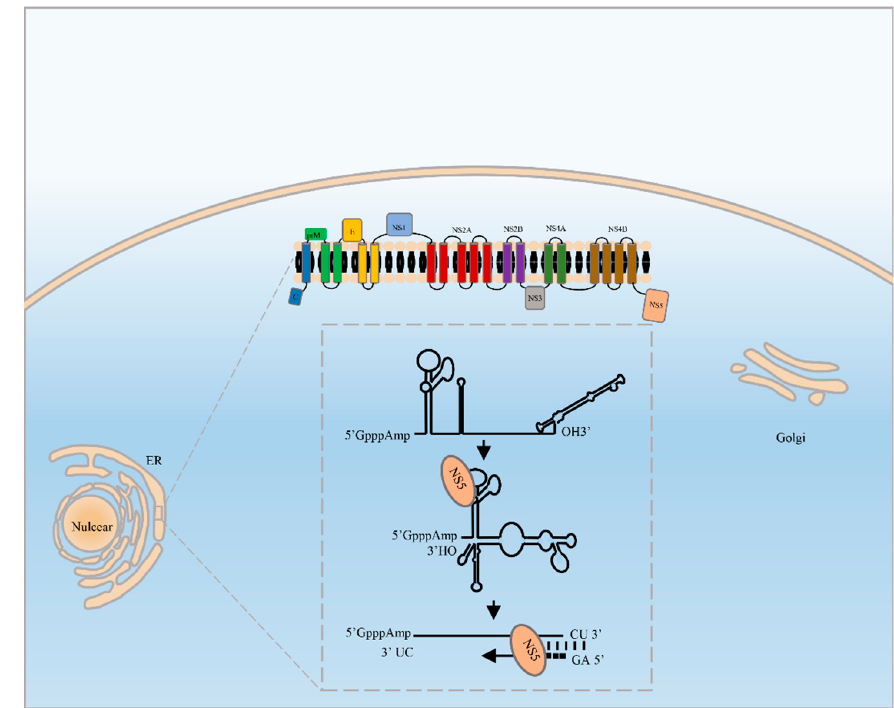
Figure 1. Schema of flavivirus genome replication. Flavivirus replication occurs on the ER of infected cells in a replication complex (RC), RdRp recognizes the 5 ′ terminal stem loop A (SLA) via long-range RNA-RNA interactions, bringing the 3 ′ end close to the 5 ′ UTR; selectively synthesizes the dinucleotide pppAG over the 3 ′ terminal RNA template as a short primer; and initiates RNA de novo replication.